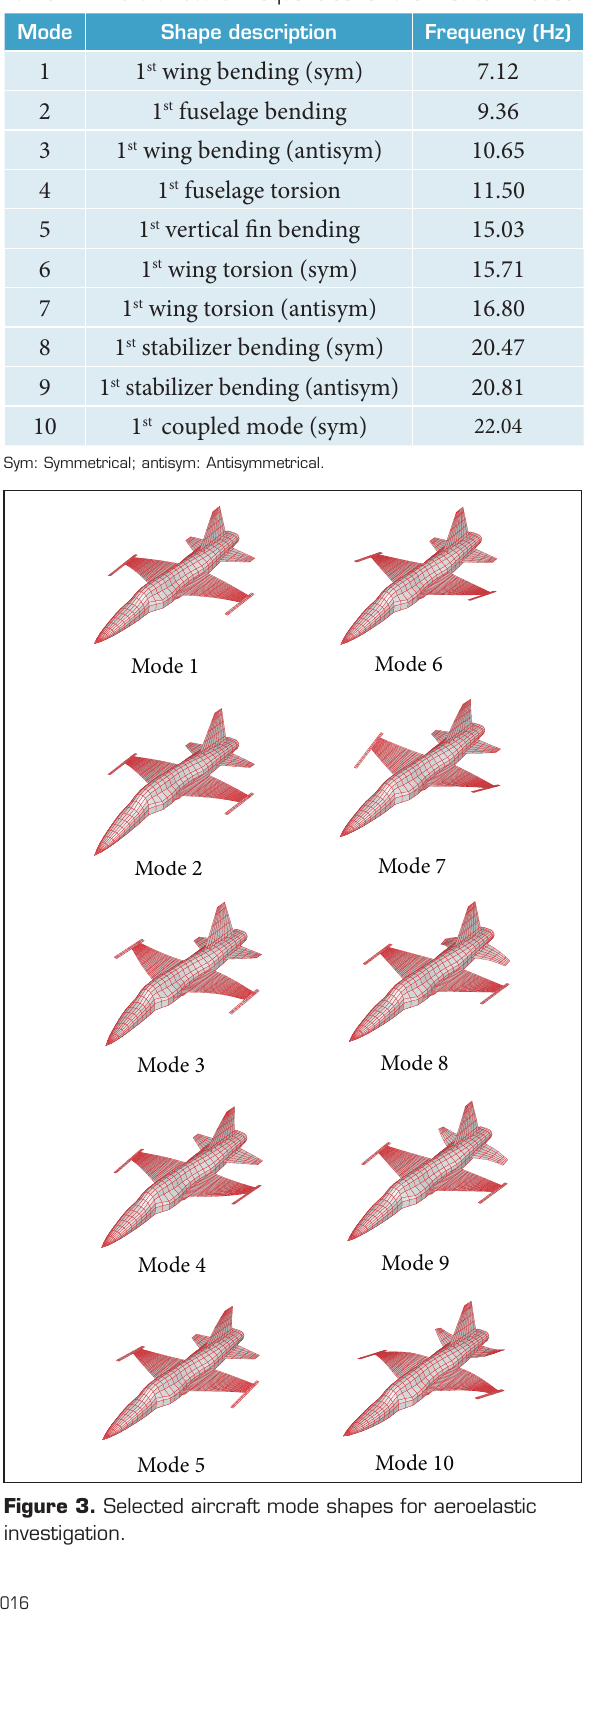
table 1. Aircraft natural frequencies for the first ten modes.